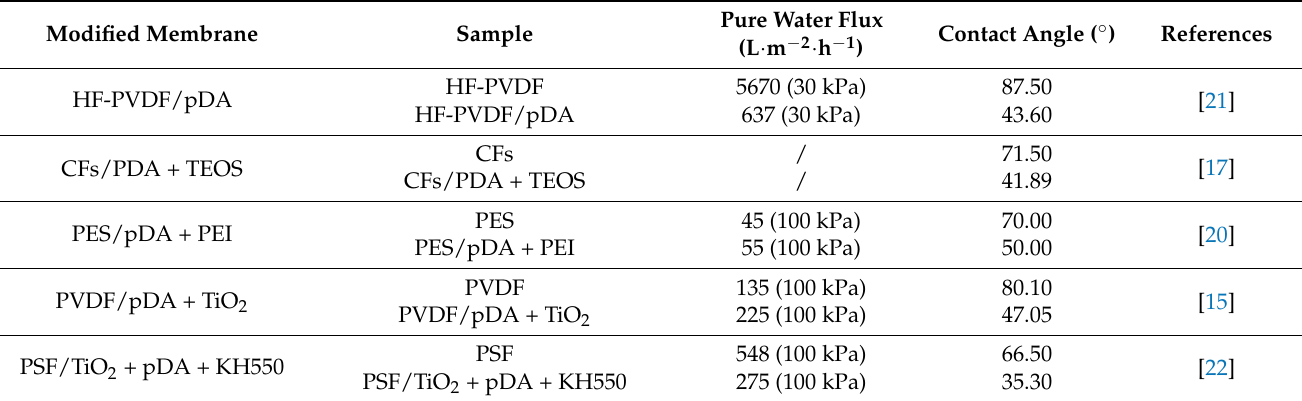
Table 1. The pure water flux and contact angle of different modified membranes reported in the literature.